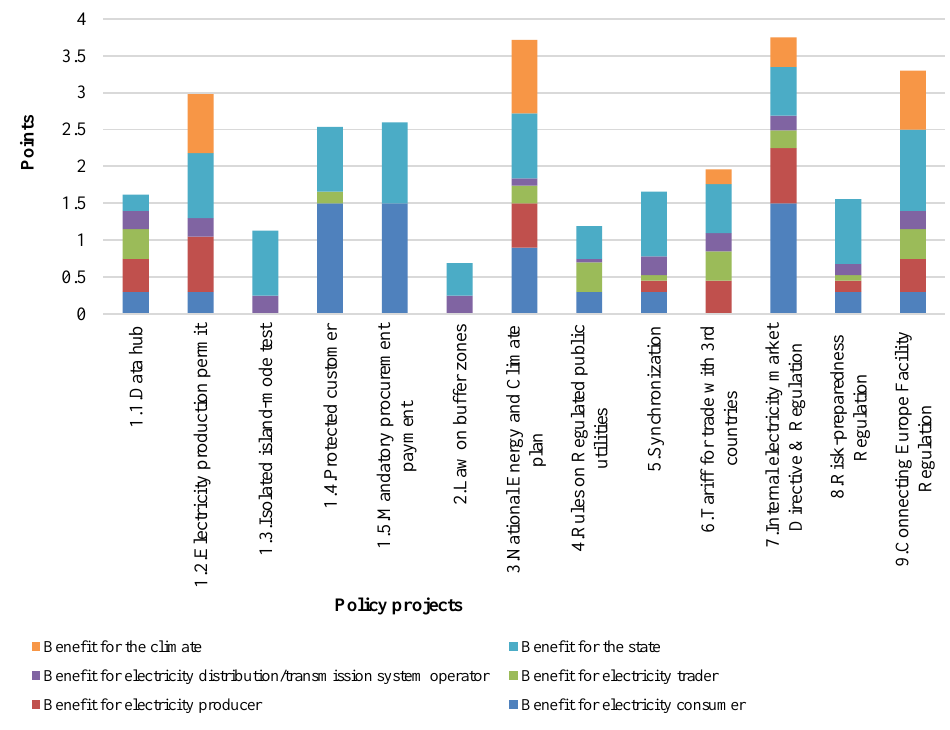
Fig. 2. Evaluation of current electricity policy